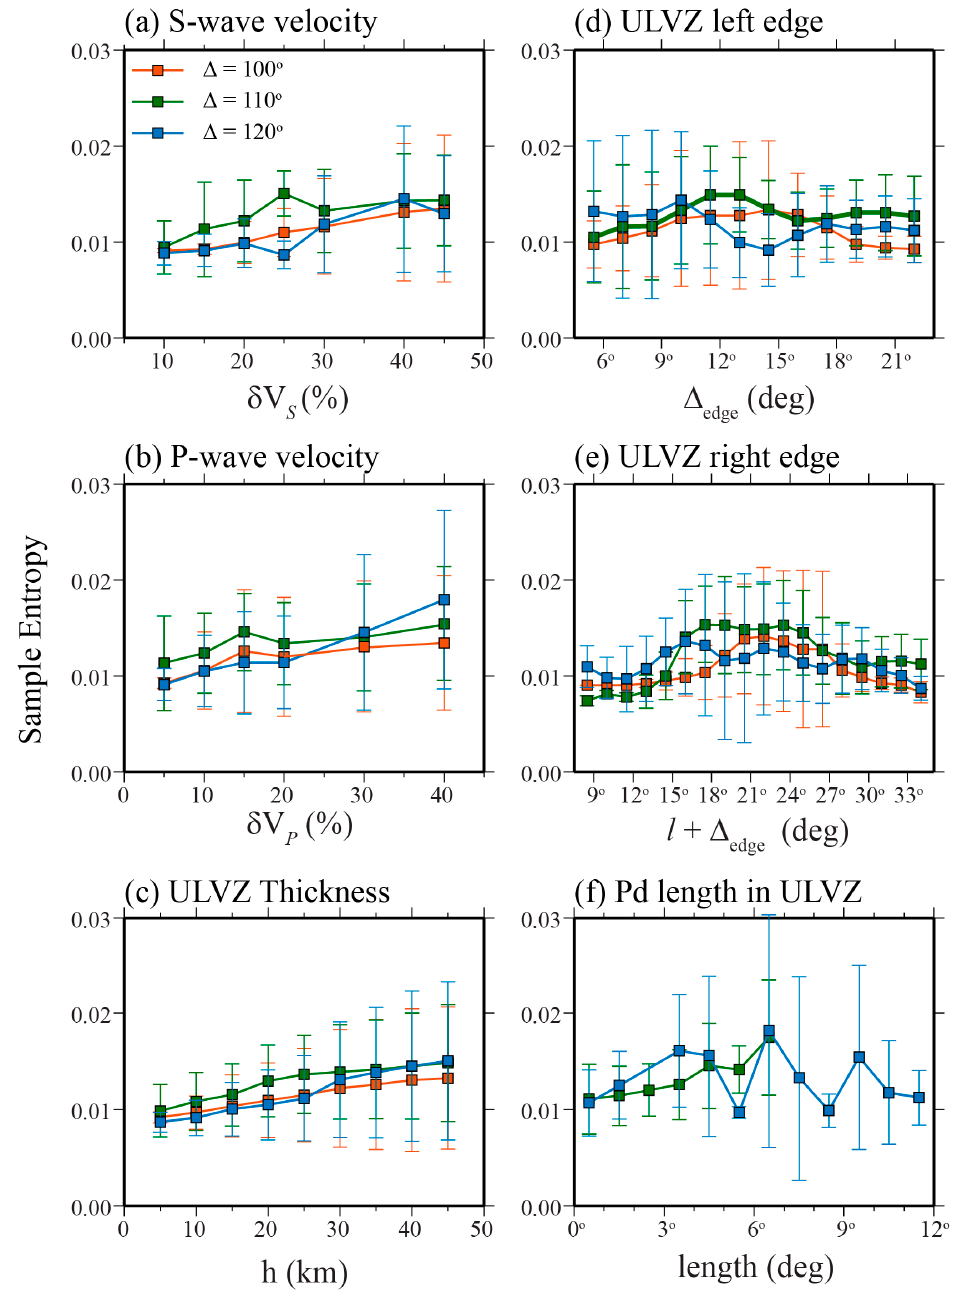
Figure 7. Variation of sample entropy with 2.5-D ULVZ parameters. The sample entropy is shown for synthetic seismograms as a function of ( a ) S-wave velocity, ( b ) P-wave velocity, ( c ) ULVZ thickness, ( d ) the leftmost edge of the ULVZ, referred to as Δ edge in the text, ( e ) the right-most edge of the ULVZ, which corresponds to l plus Δ edge , and ( f ) the length of the Pd portion of SPdKS that travels within the ULVZ. In all panels the answers are shown for synthetics at epicentral distance of Δ = 100° (red lines and squares), Δ = 110° (green lines and squares), Δ = 120° (blue lines and squares). The error bars show 1- σ standard deviation.